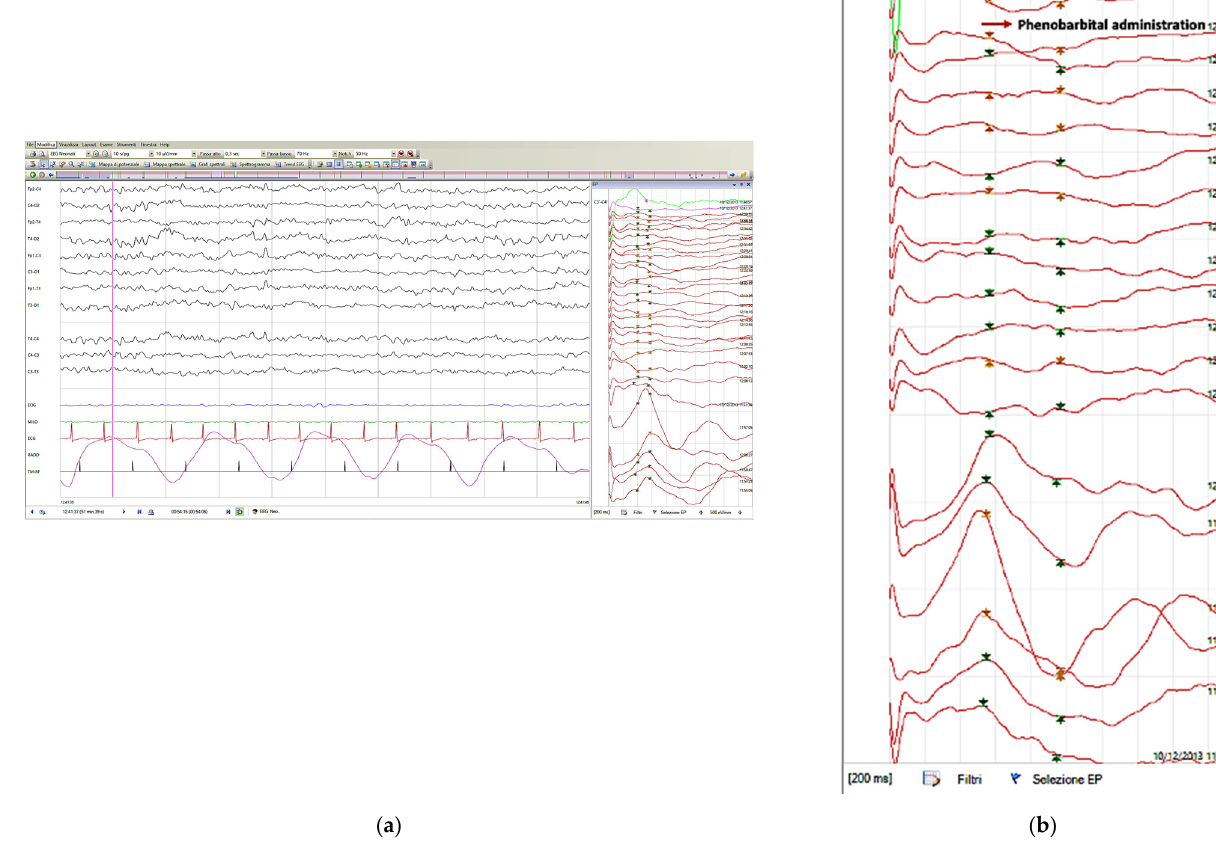
Figure 2. The giant SEP ( a , b ) left cortical component after the end of EEG manifestation and pheno- barbital administration. ( b ) Chronological order from bottom to top.